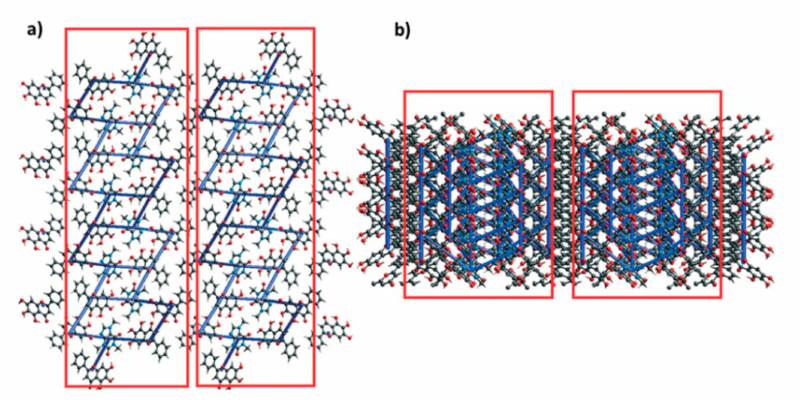
Figure 9. ( a ) Crystal packing diagram (hydrogen bonds are shown as blue lines) and ( b ) energy framework of BAI α form viewed into c axis (radius of each cylinder represents the relative strength of interaction). The threshold interaction energy is set at − 5 kJ mol − 1 [69] (Reproduced from ref. [69] with permission from the Royal Society of Chemistry).